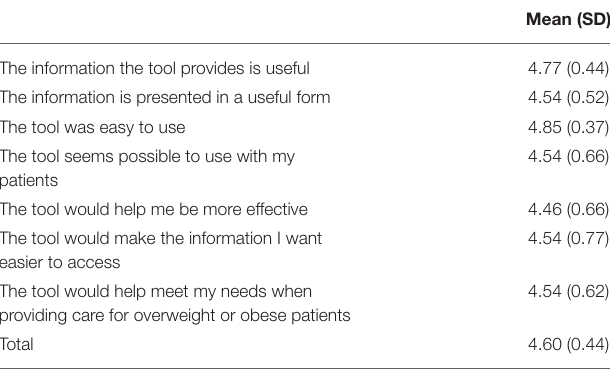
TABLE 4 | Provider satisfaction survey